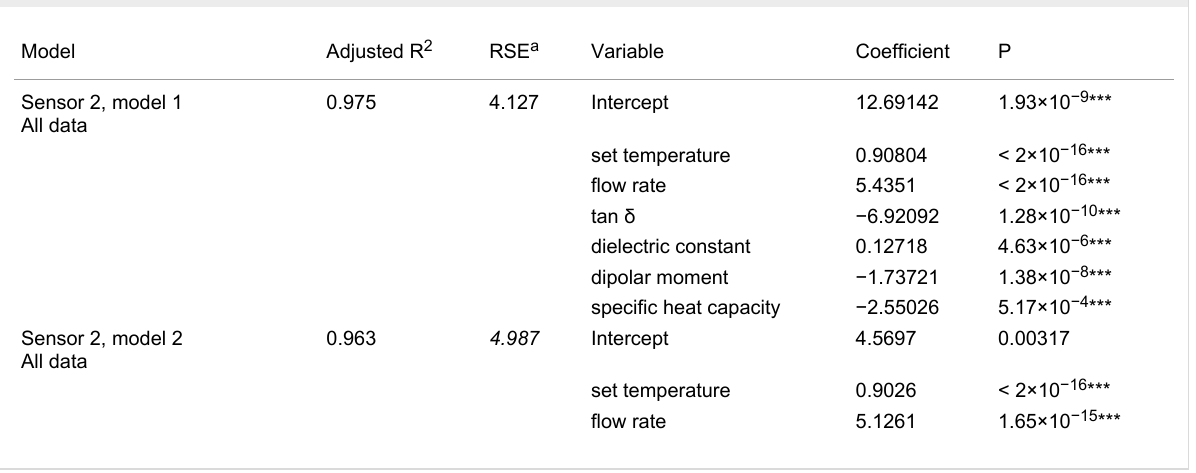
Table 3: Linear multiple regression models for IR sensor